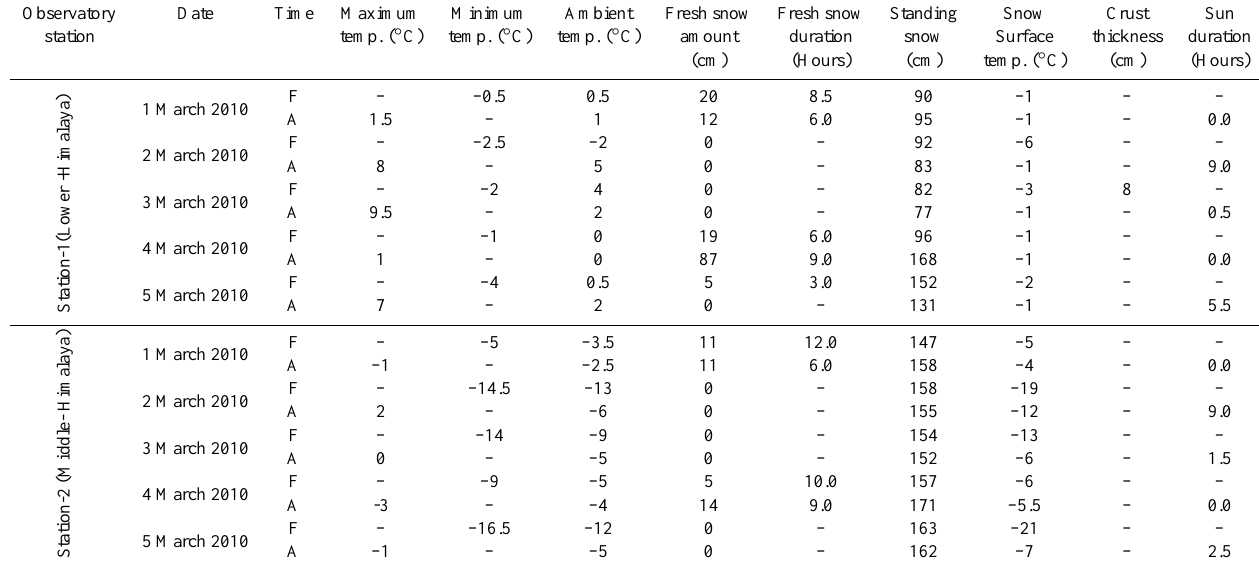
Table 5. Field collected snow meteorological data recorded at 08:30 (F) and 17:30 (A) local time for representative stations of lower and middle Himalaya.